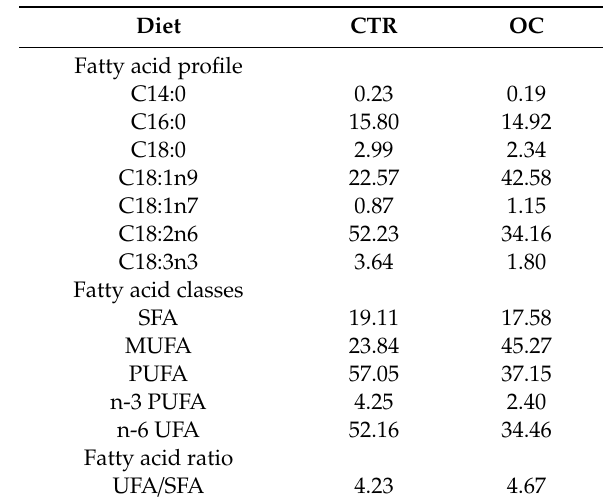
Table 3. Fatty acids of nutritional interest, fatty acid classes (g / 100 g FAME) # and unsaturated / saturated fatty acids ratio of the concentrates.